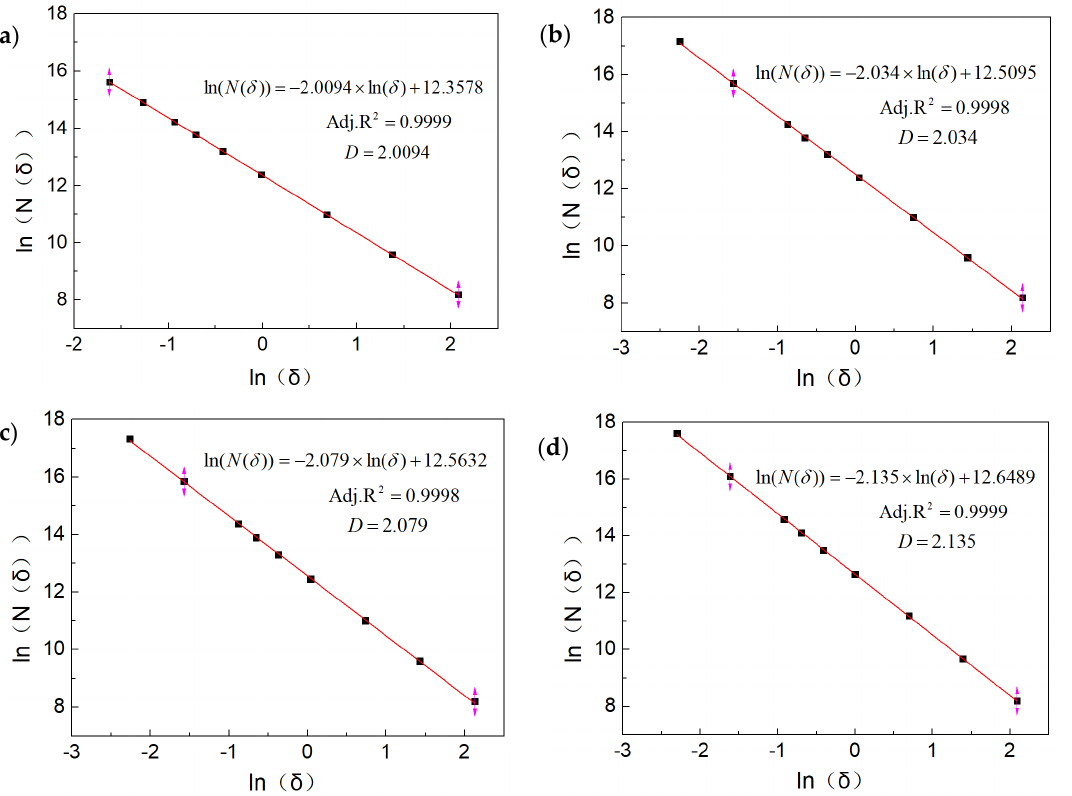
Figure 10. Dual logarithmic coordinate graphs of concrete specimens corroded for 0 days, 31 days, 93 days, and 154 days to calculate fractal dimensions. ( a ) Concrete uncorroded ( D = 2.0094); ( b ) Con- crete corroded for 31 days ( D = 2.034); ( c ) Concrete corroded for 93 days ( D = 2.079); ( d ) Concrete corroded for 154 days ( D =